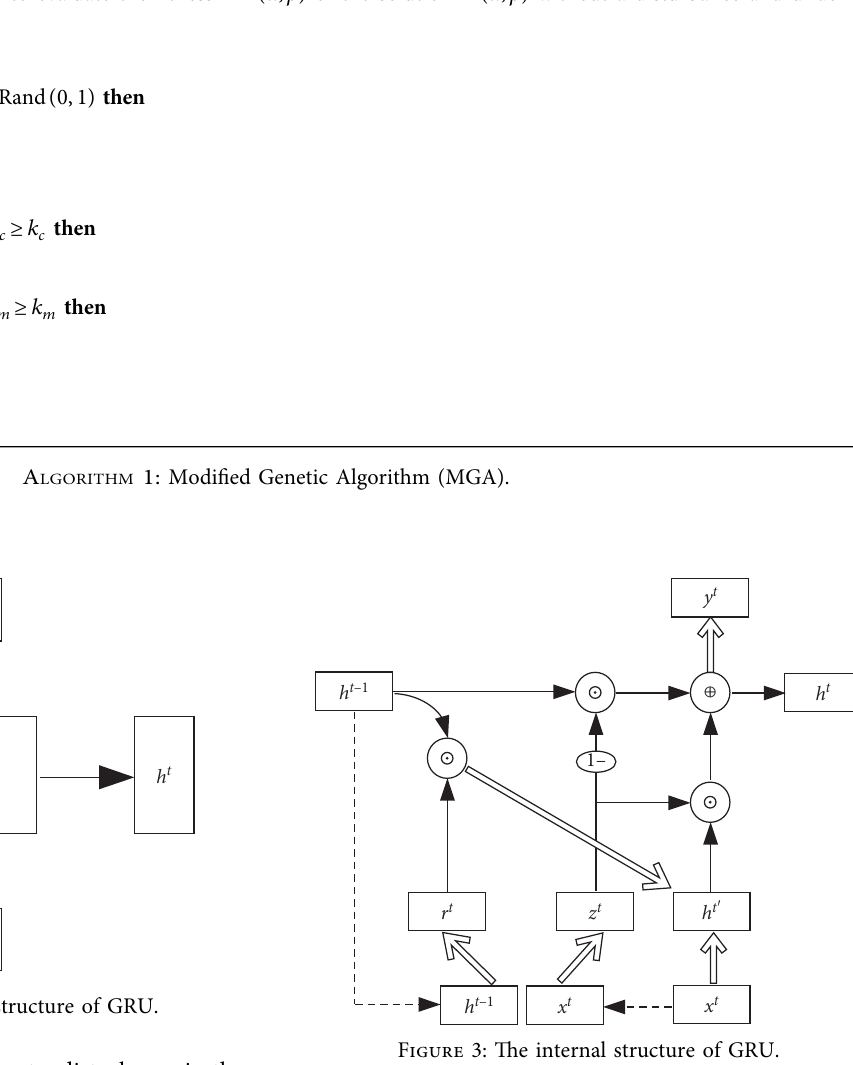
Figure 5. The configuration of the numerical experiment is shown in Table 1.